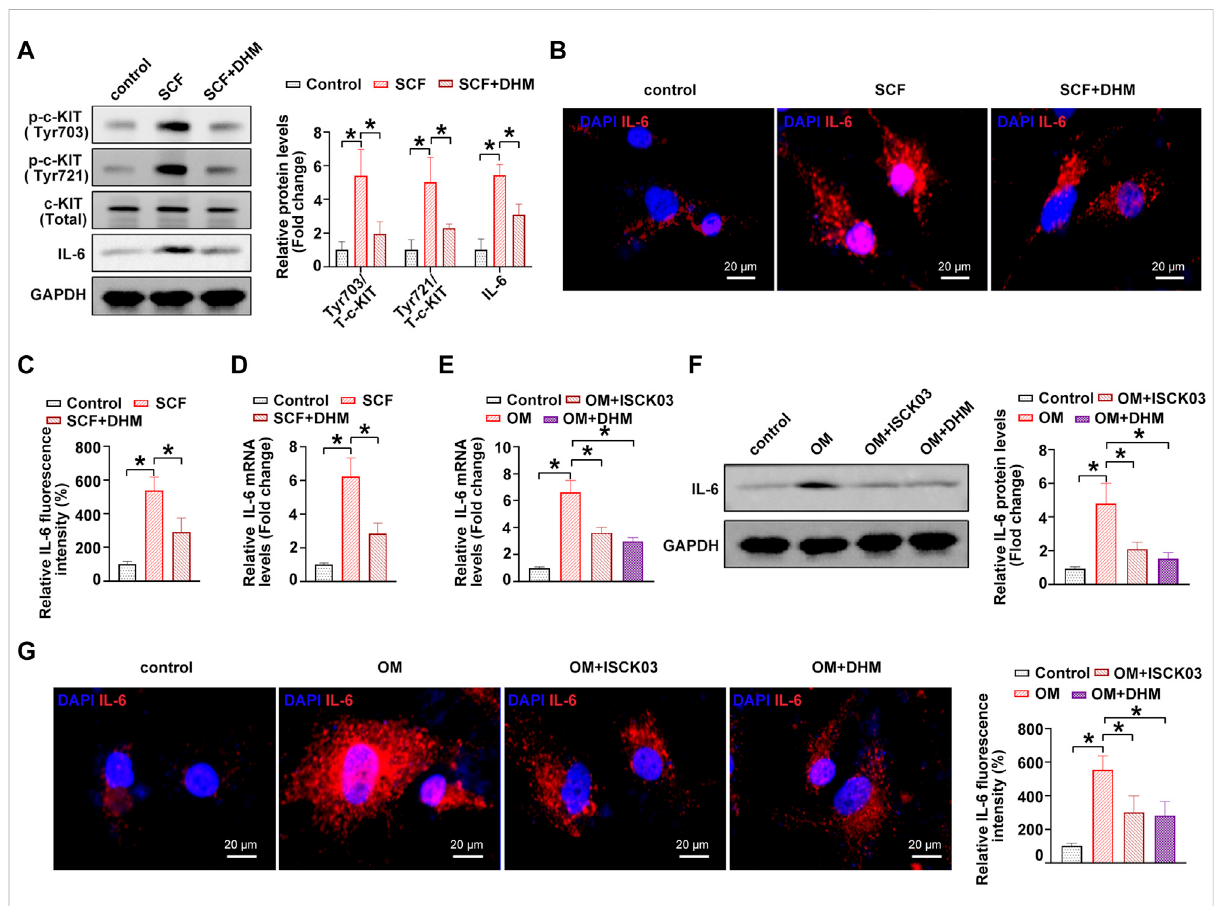
FIGURE 4 Dihydromyricetin (DHM) represses interleukin-6 (IL-6) through c-KIT inhibition in human valvular interstitial cells (hVICs). (A) IL-6 and phosphorylated c-Kit (sites of Tyr703 and Tyr721) protein levels in hVICs stimulated with stem cell factor (SCF, 100 ng/ml), the c-kit ligand, or cotreatedwithDHM.One-wayANOVAfollowedbyBonferroni posthoctest . (B) Immuno fl uorescentstainingwasusedtodetecttheproteinlevelsof IL-6 in hVICs following different conditioned culturing conditions. (C) Semiquanti fi cation of the fl uorescence intensity of IL-6. One-way ANOVAfollowedbyBonferroniposthoctest.One-wayANOVAfollowedbyBonferroni posthoctest . (D) mRNAlevelofIL-6inhVICsstimulatedwith SCF and then treated with or without DHM. One-way ANOVA followed by Bonferroni post hoc test . (E) IL-6 mRNA levels in hVICs stimulated with osteogenicinductionmedium(OM),orcotreatedwithISCK03orDHM.One-wayANOVAfollowedbyBonferroni posthoctest . (F) IL-6proteinlevels in hVICs stimulated with OM or cotreated with ISCK03 or DHM. One-way ANOVA followed by Bonferroni post hoc test . (G) Immuno fl uorescent staining was used to detect the protein level of IL-6 in hVICs following different conditioned culturing conditions. One-way ANOVA followed by Bonferroni post hoc test . N = 3 per group. Values are the mean ± SD. * p < 0.05 indicates a signi fi cant